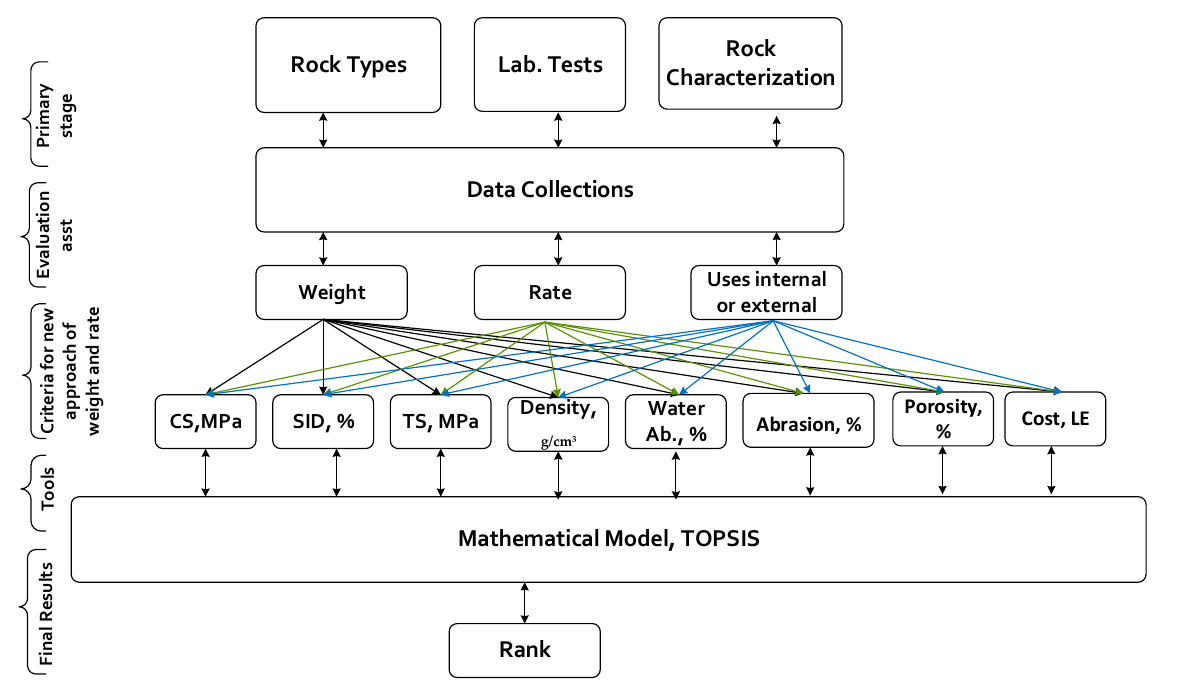
Figure 3. Flowchart of the evaluation process.